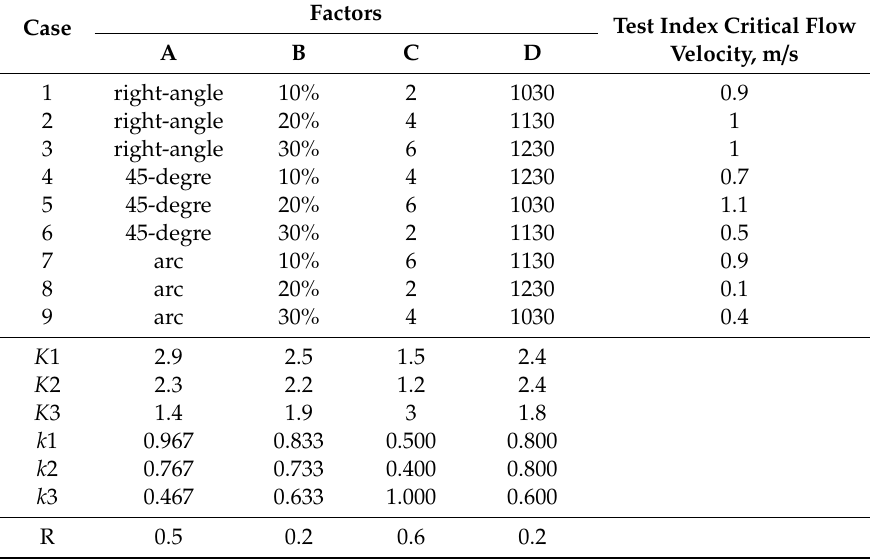
Table 2. Results of orthogonal test analysis on rock carrying capacity.